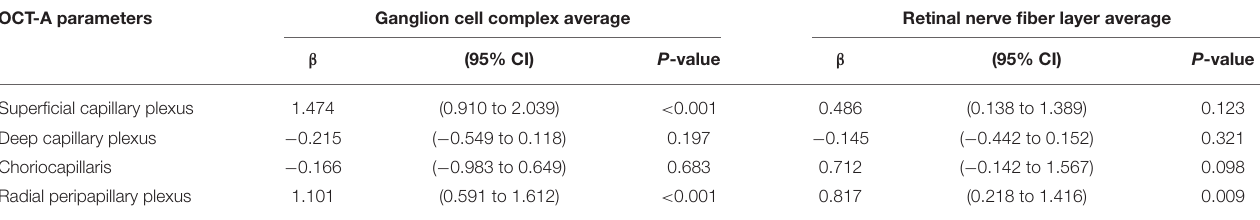
TABLE 4 | Correlations between OCTA and OCT parameters in the group including IDE and RRMS patients. OCT-A